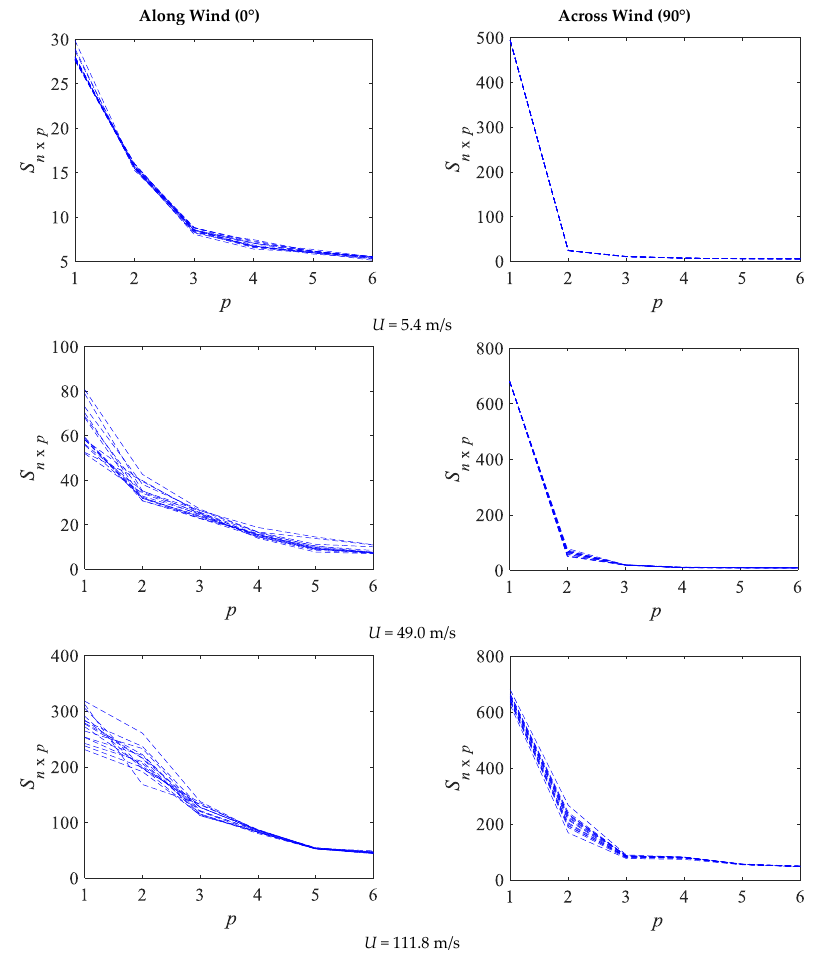
Figure 4. Variability of the singular values 𝑆 𝑛 × 𝑝 with different velocities.